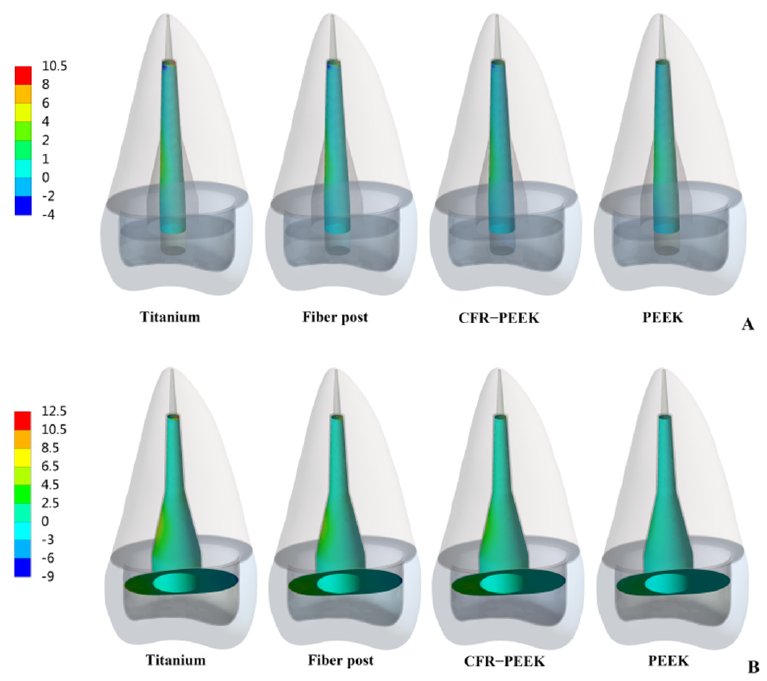
Figure 8. Distributions of MPS at post–root cement interface. ( A ) Prototype 2. ( B ) Prototype 3.